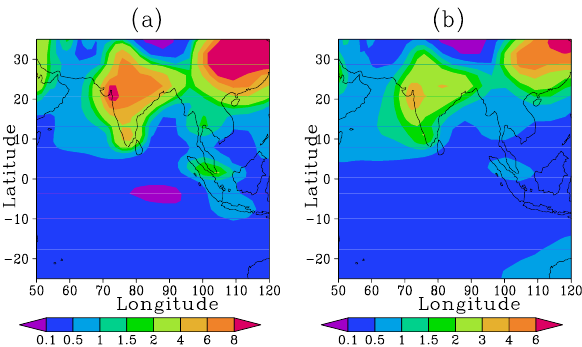
Fig. 9. Average SO 2 distribution for January to March 1999 for the INDOEX domain: (a) surface concentration (µg SO 2 m − 3 ) ; (b) col- umn burden (mg S m − 2 ) .